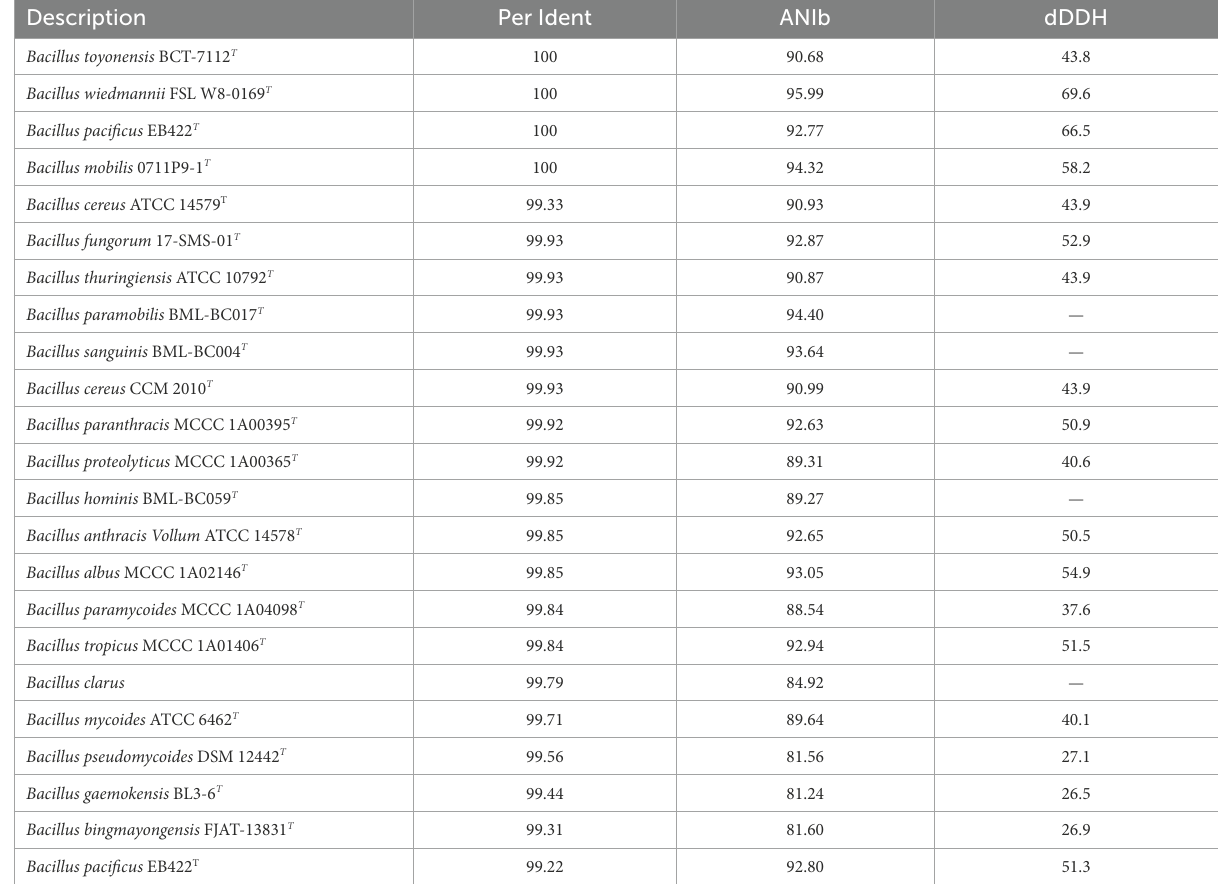
TABLE 5A Similarity of the 16S rRNA gene greater than 98.65% of all type strains against SAICEU11 T .